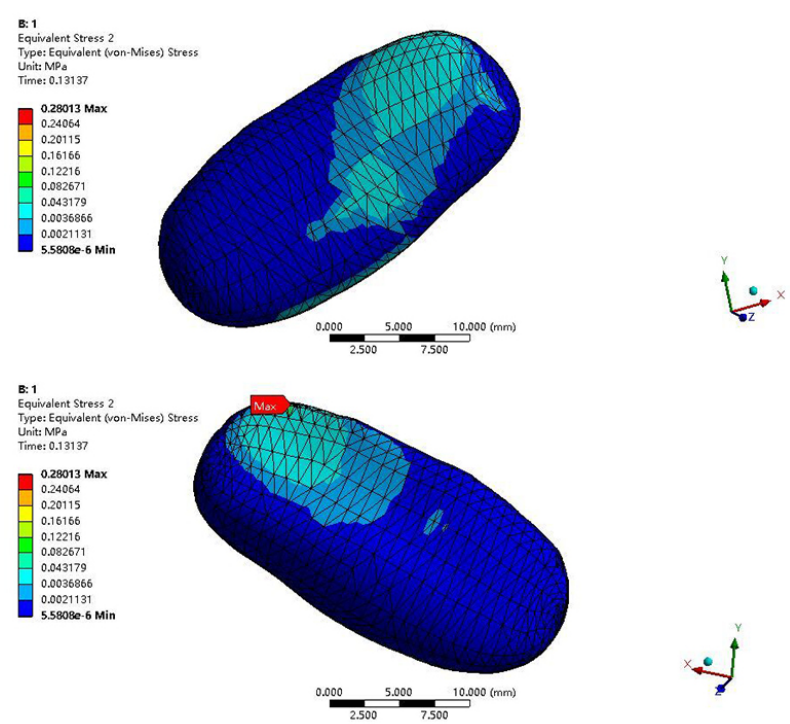
Fig. 3. Stress change at the start of the subacromial bursa raising the bow stage.